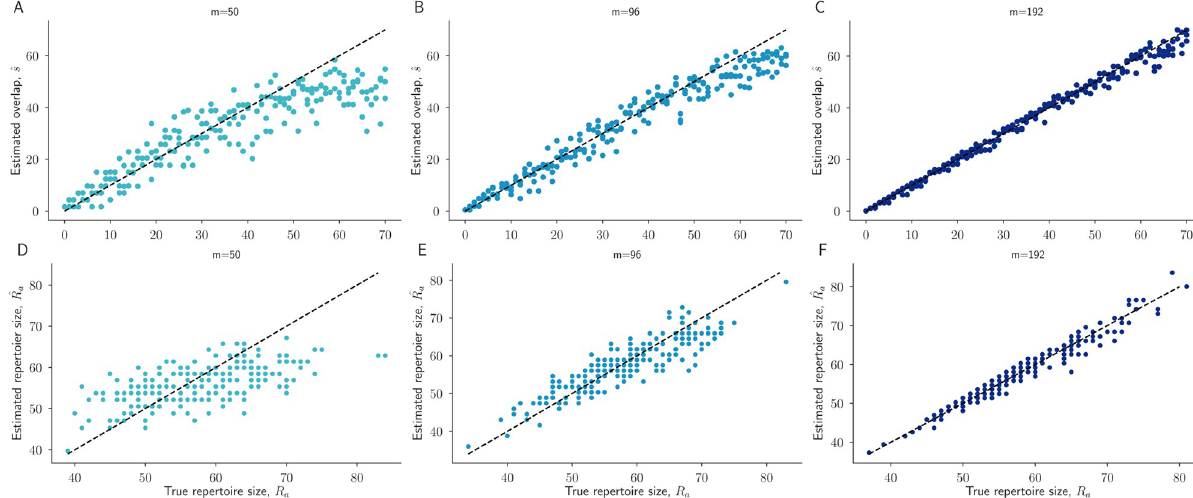
Fig 3. Accuracy of estimates across a range of true parameter values and sampling efforts. For each overlap value s between 0 and 70, we performed three independent simulations to generate synthetic count data (Methods). Estimates of s (A,B,C) and R our statistical model, are shown. Estimates are shown for sampling efforts m a = m b = m = 50, 96, 192 across left, middle, and right columns, respectively. Dashed black lines represent perfect unbiased inference.